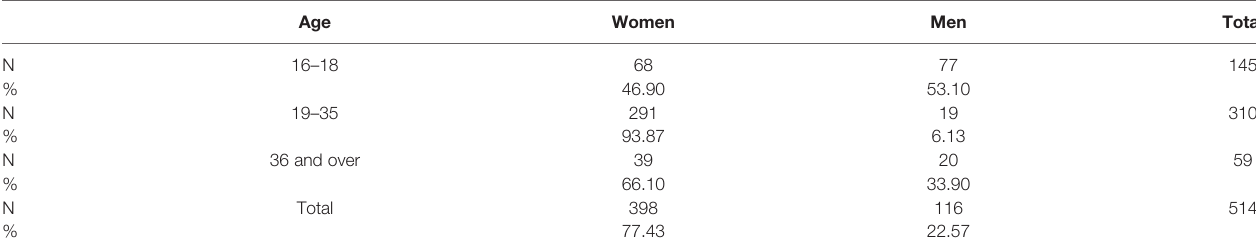
TABLE 1 | Sample strati fi cation by age and gender